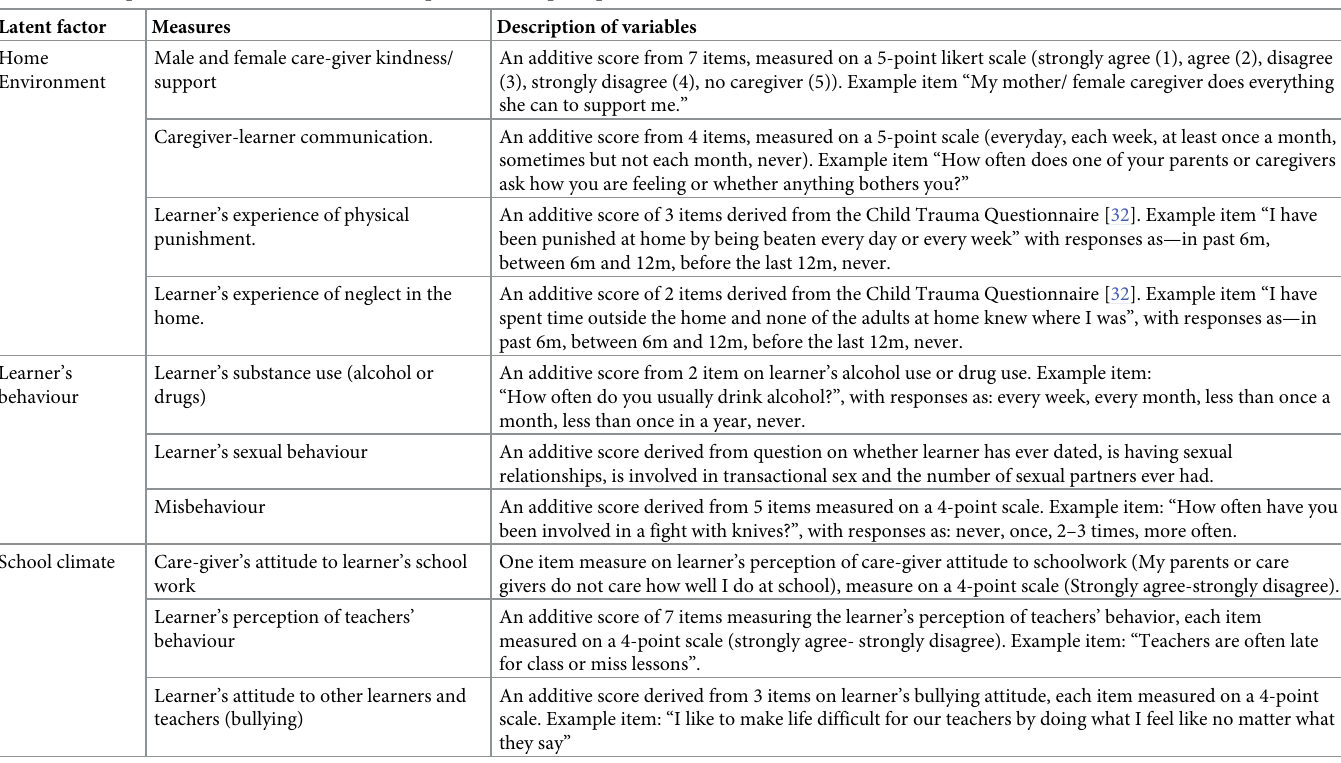
Table 1. Description of the factors that influence experience of corporal punishment at